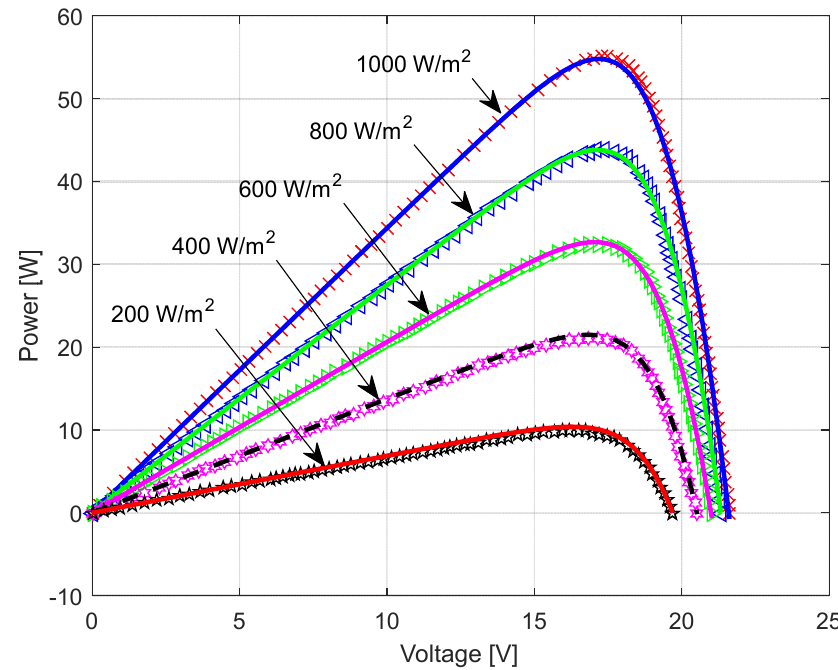
Figure 17. Power-voltage characteristics at 25 °C for different irradiance levels.